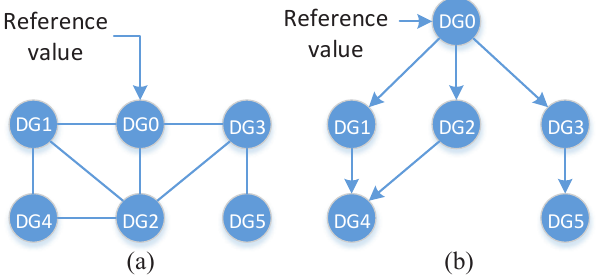
Figure 1. The communication topology of an AC microgrid: ( a ) the general communication topology; ( b ) the hierarchical topology after